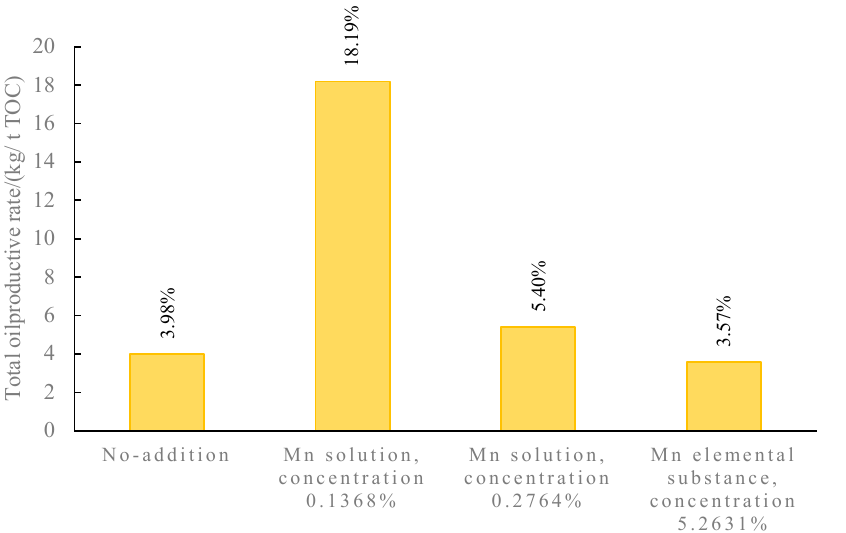
Figure 3. Comparison diagram of different forms of Mn element addition on oil production rate in thermal simulation experiment (adapted from [84]).